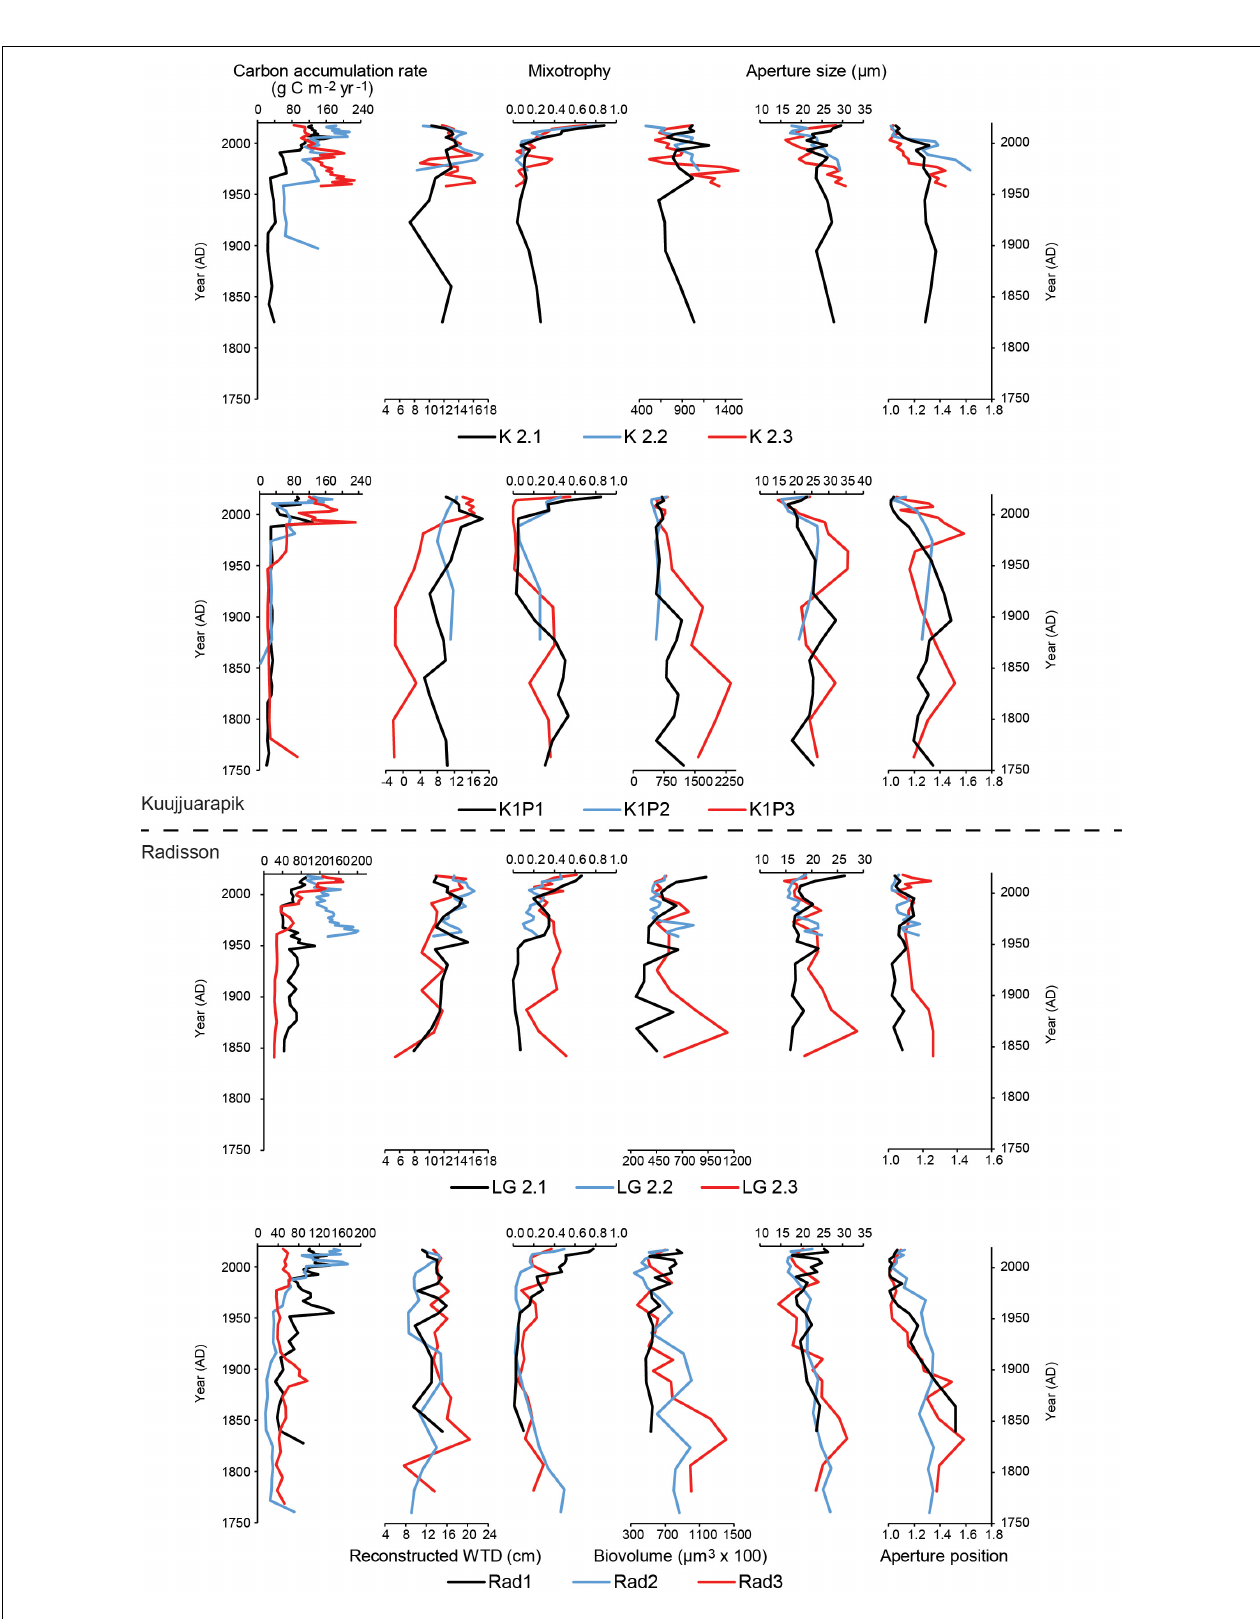
FIGURE 4 | Diagrams of carbon accumulation rates, reconstructed water-table depth (WTD), mixotrophy, biovolume, aperture size and position of testate amoebae for the studied peat records.